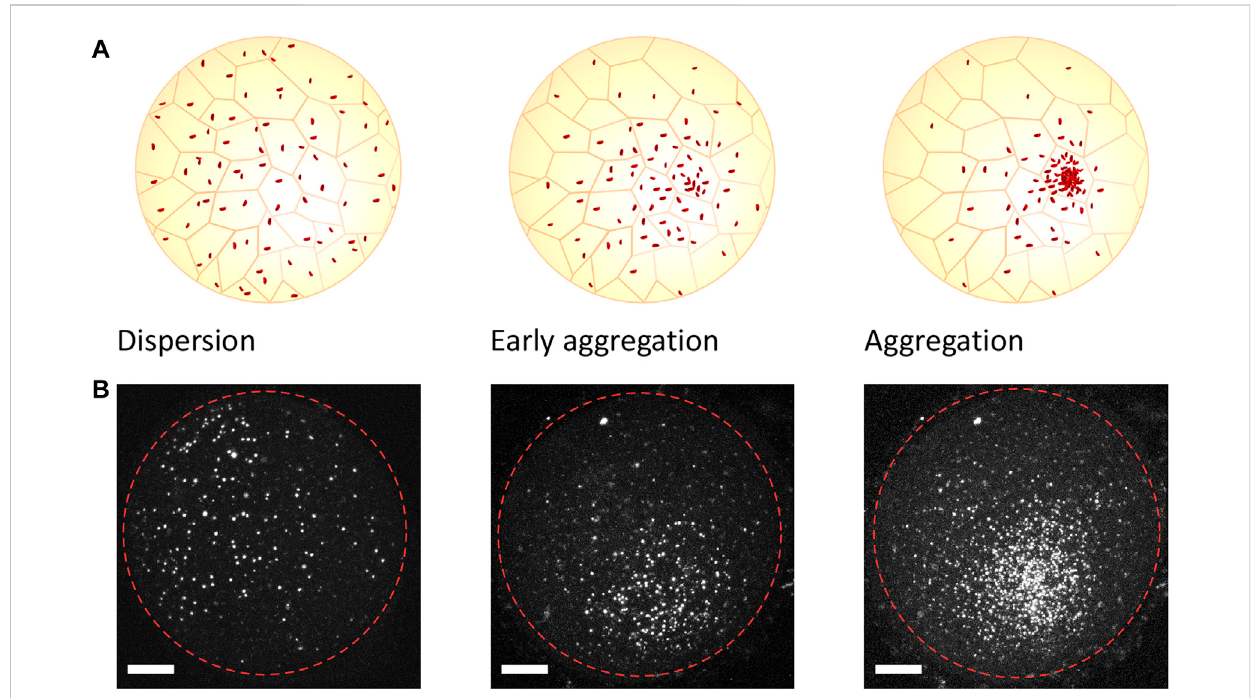
FIGURE 1 Stagesoftheearlydevelopmentofannualkilli fi shasrecorded invivo .Cartoonrepresentation (A) andconfocalimagesofembryoniccellnuclei (B) stainedusingthe FUCCIconstruct,illustratingthestagesoftheearlydevelopmentofkilli fi shembryos.Followingthedispersivestate(left),thecellsmovedirectionallytowardapoleofthe embryo (center) and form an aggregate (right). The dashed red circles indicate the approximate outline of the embryo. The time between the stages varies between several hours to a few days, depending on the environmental condition and speci fi c killi fi sh species (Dol fi et al., 2014; Márquez et al., 2019). Scale bar, 200 μ m.